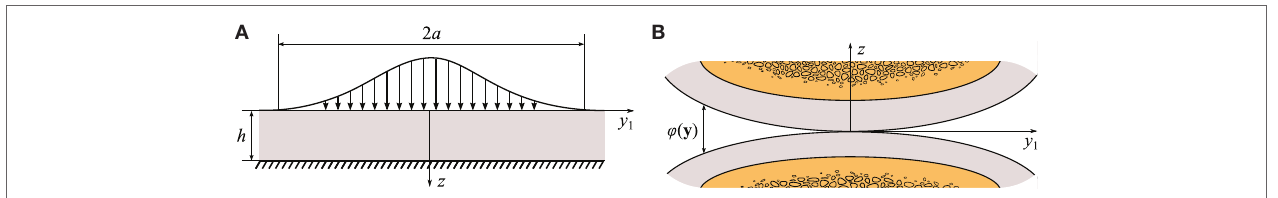
FIGURE 1 | (A) Model problem for the deformation of articular cartilage layer [after Ateshian et al. (1994)]; (B) schematics of the initial contact geometry between two cartilage layers bonded to subchondral bones.